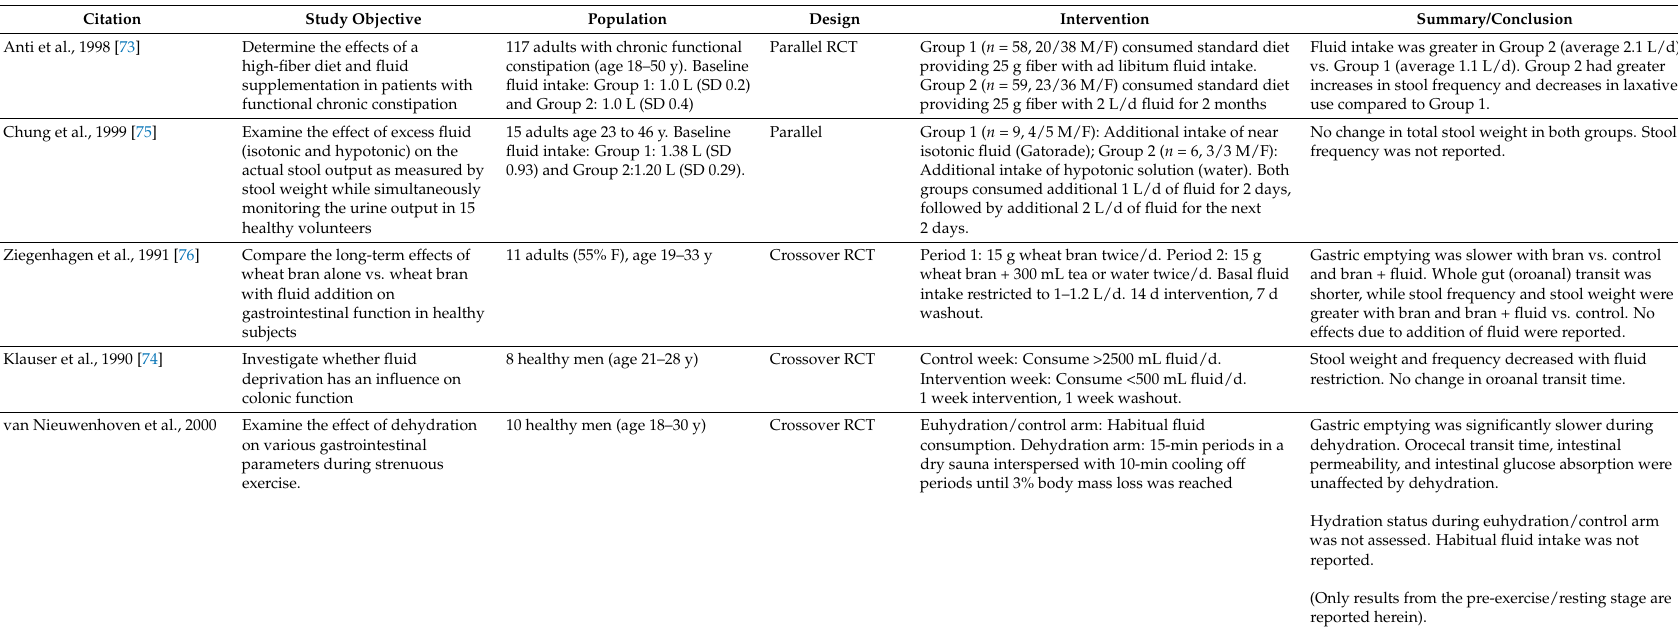
Table 3. Intervention Studies on Hydration and Gastrointestinal Function 1